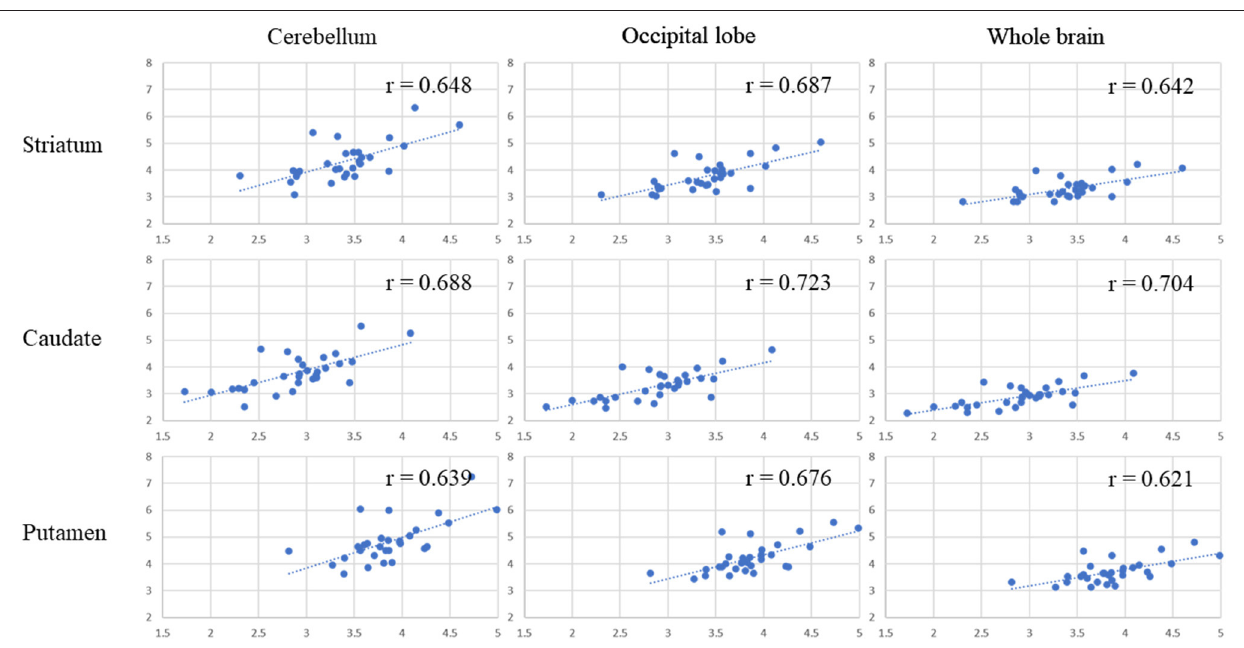
FIGURE 4 | Correlation between the SUR, CUR, and PUR of DAT-SPECT and those of DAT-PET in the multi-atlas MRI-based method. In each correlation figure, the vertical axis indicates the semi-quantitative uptake for DAT-SPECT, and the horizontal axis indicates the semi-quantitative uptake for DAT-PET. There are 3 × 3 correlation figure patterns in two different cases: where the target region is the striatum, caudate, or putamen and where the reference area is the cerebellum, occipital lobe or whole